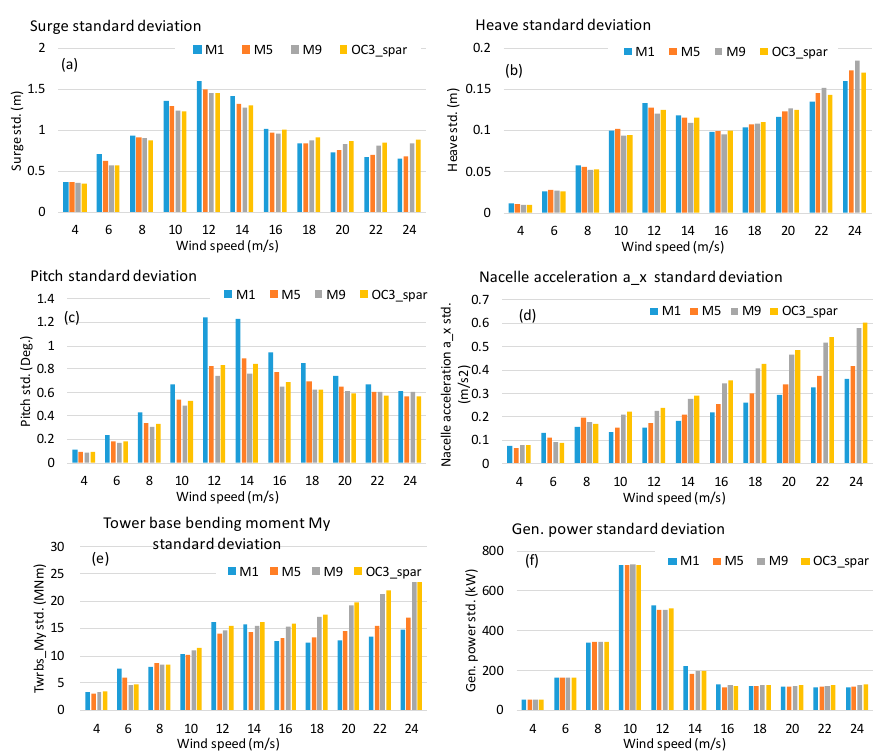
Figure 11. Standard deviation of models M1, M5, M9, and the OC3-Hywind model in DLC1.1 - normal operation cases: ( a ) surge, ( b ) heave, ( c ) pitch, ( d ) nacelle acceleration, ( e ) tower-base bending moment My, and ( f ) generator power. Energies 2019 , 12 , x FOR PEER REVIEW